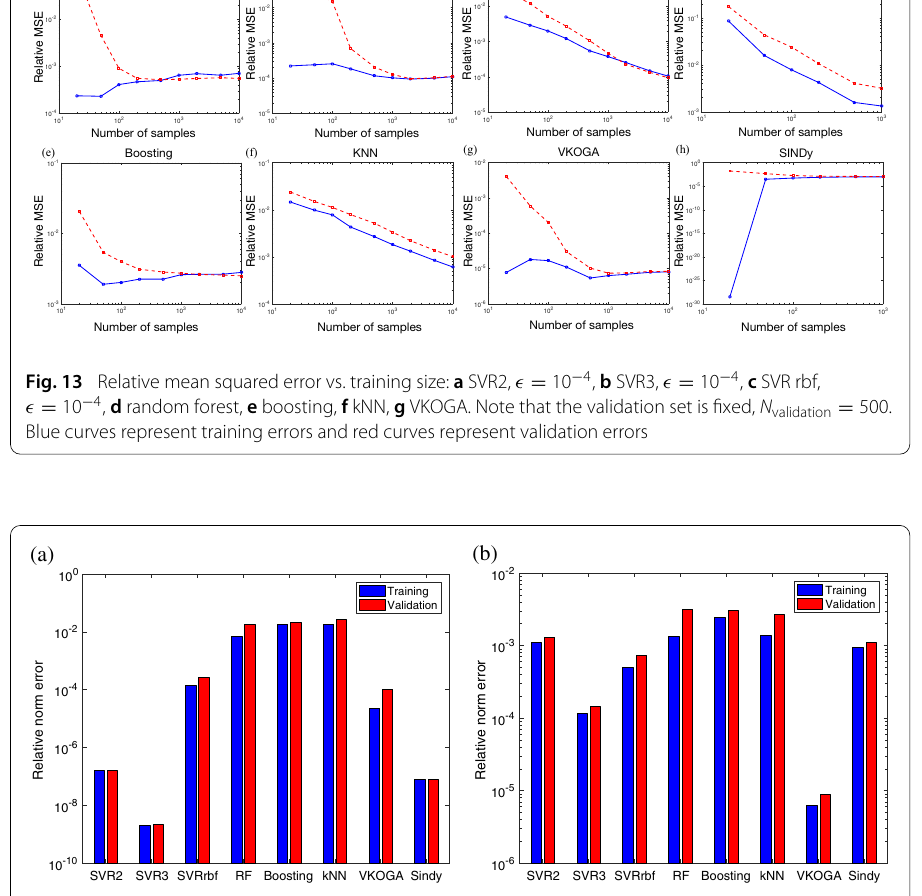
Fig. 14 Relative errors with N training = 1000 and N validation = 500: a 1D Burgers’ equation; and b 2D convection–diffusion equation. Blue bars represent training errors and red bars represent validation